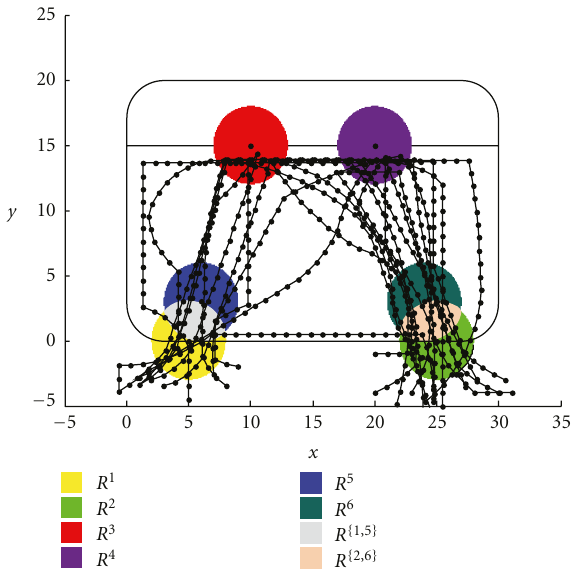
Figure 17: Illustration of the simulation configuration with overlapping regions ( R 1,5 and R 2,6